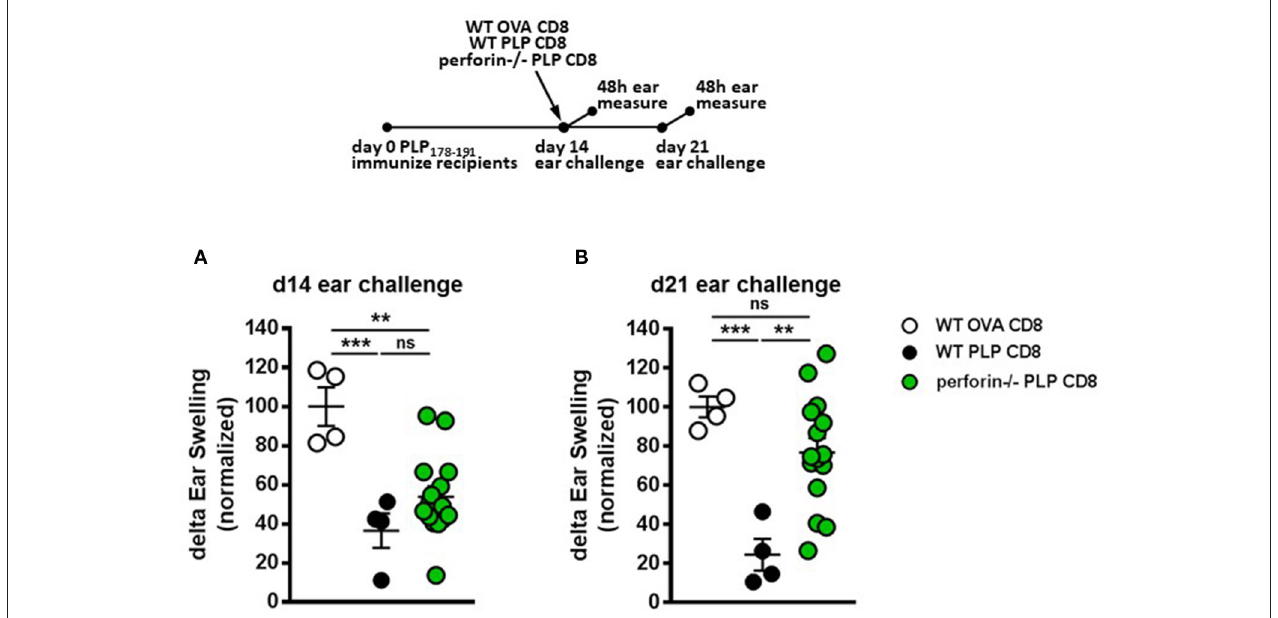
FIGURE 4 | Perforin production by PLP-specific CD8T cells is not required for rapid suppression of PLP-specific CD4T cell responses in vivo but is required for late phase suppression. (A) Mice were immunized with PLP178-191/CFA on day 0. On day 14, mice were treated with either WT OVA-CD8, WT PLP-CD8, or perforin–/– PLP-CD8. On the same day, ears were challenged with PLP178-191 peptide. Ear swelling was measured at 48h. (B) In the identical setup as (A) , ears were challenged at day 21 (7 days post-CD8 treatment) and swelling was measured at 48h. OVA-CD8 n = 4; WT PLP-CD8 n = 4; perforin–/– PLP-CD8 n = 15. Data are representative of two replicate experiments. ** p < 0.01; *** p <